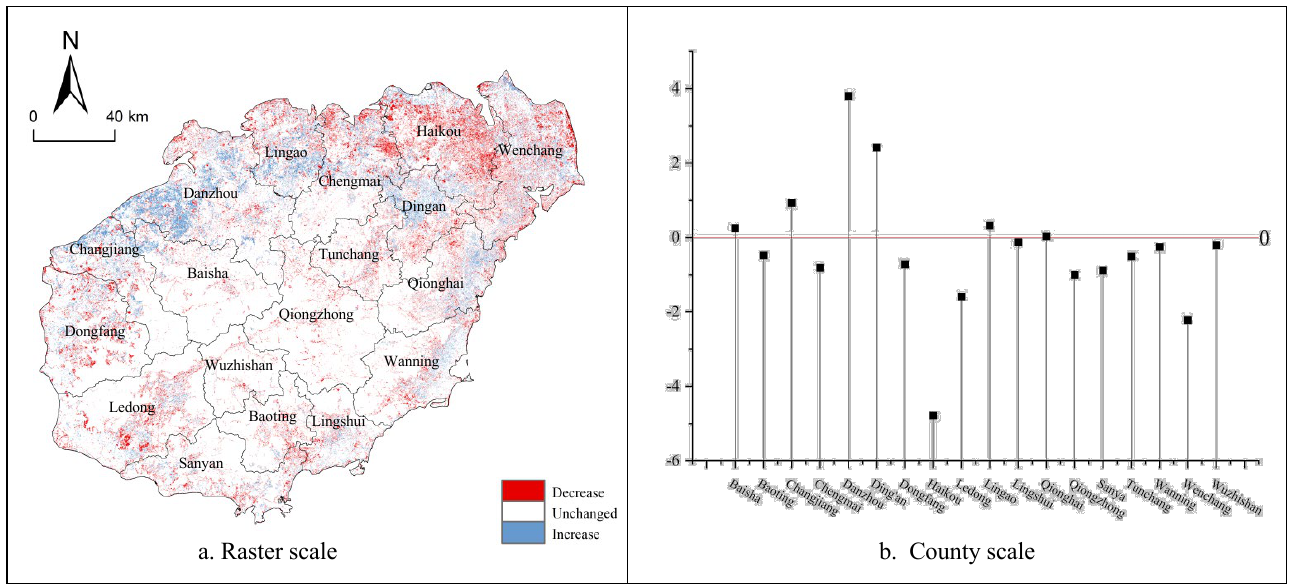
Figure 6. Net spatio-temporal impact of ESV for the ITIS.